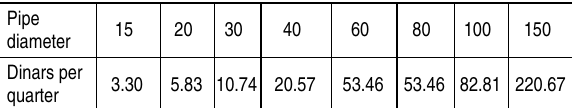
Table 2. Fixed charges for water distribution